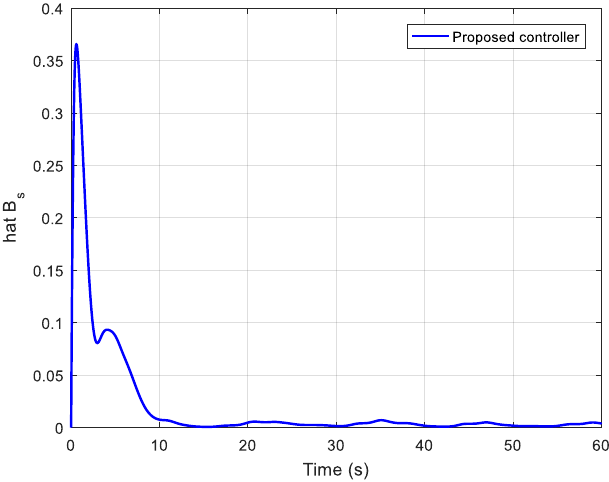
ˆ B . Figure 7. Profile of the adaptive parameter ˆ B .